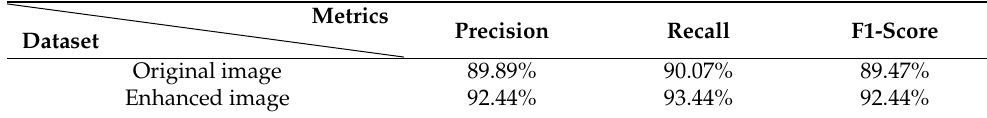
Table 4. Experimental results of face